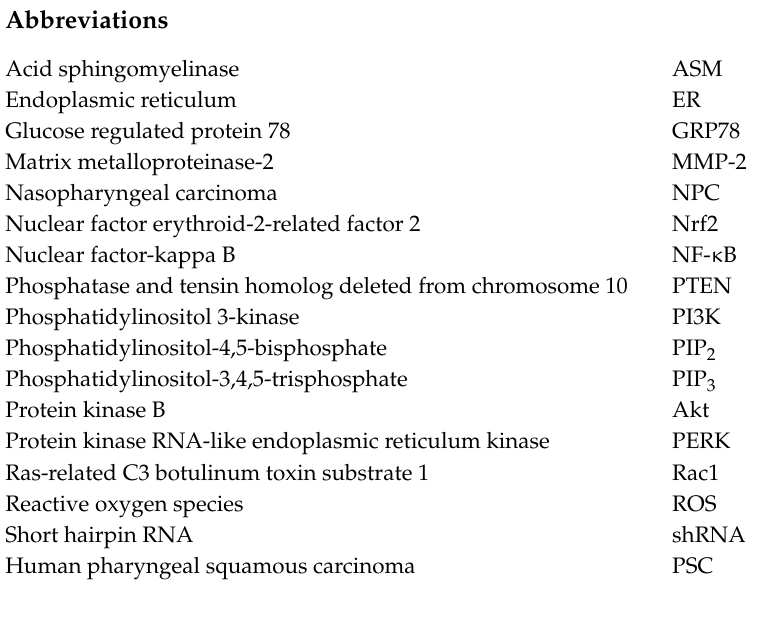
Figure S1: The e ff ect of TSWU-BR4 on the cell surface localization of GRP78. Author Contributions: T.-L.L. and S.-G.W. performed the experiments, collected the data, and performed statistical analysis. W.-L.C. and C.-H.L. performed several experiments. T.-S.W. created the TSWU-BR4. S.-S.C. and